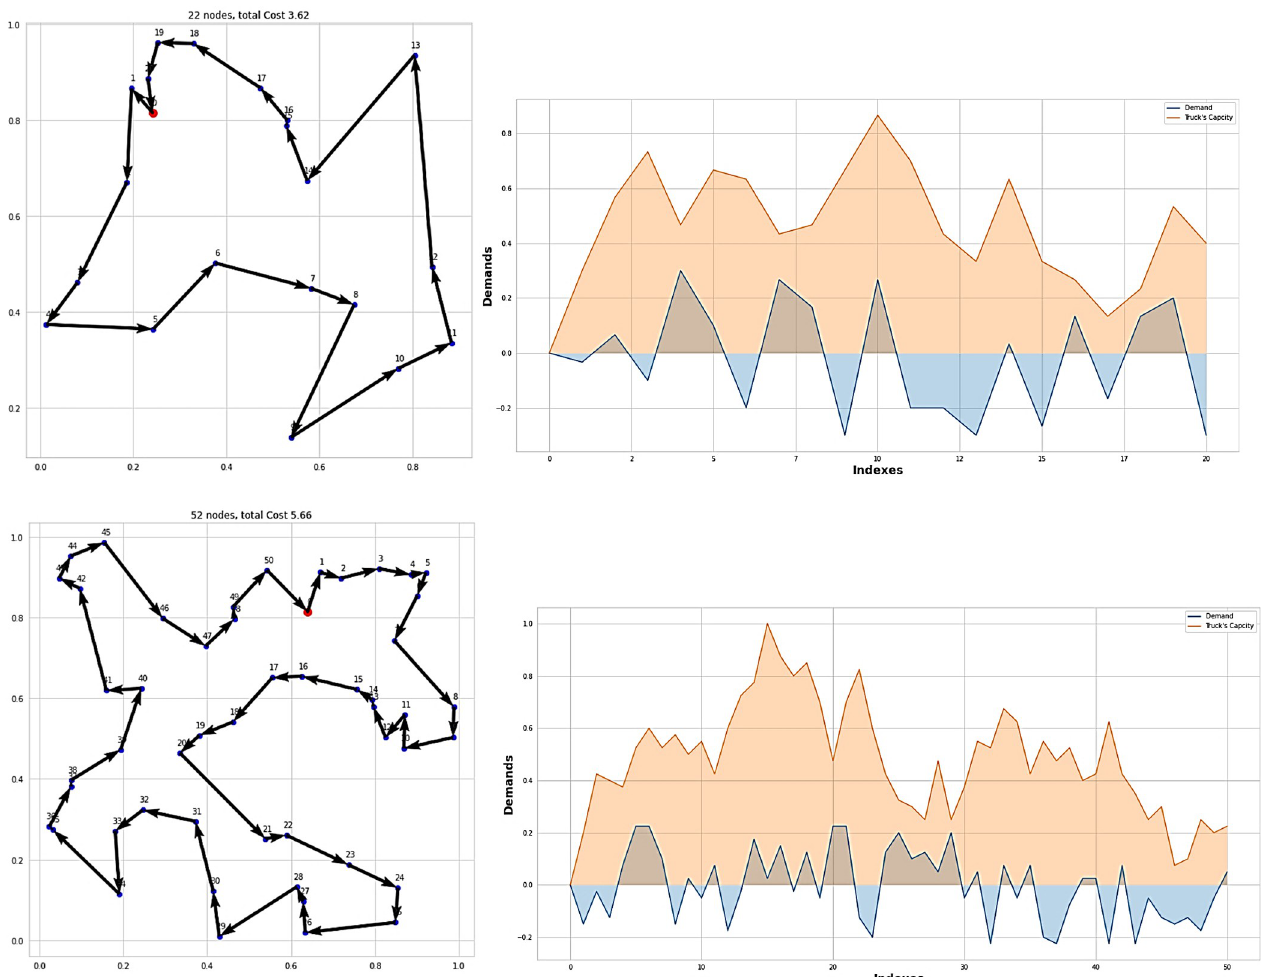
Fig 5. Sample instances for PDP21 and PDP 51, with each point labeled with its demand and the vehicle remining capacity once the vehicle served this point.